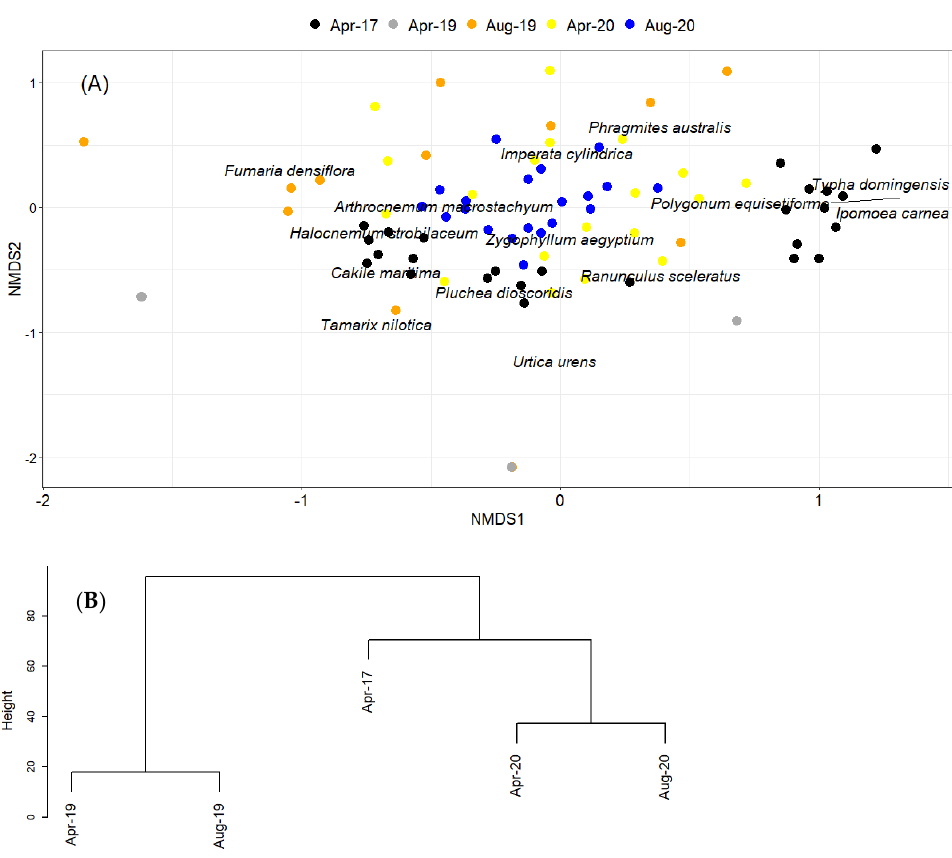
Figure 1. ( A ) NMDS ordination of plots at different sampling events (displayed by colors) and the species recorded during the surveys. ( B ) Hierarchical clustering of plots at different sampling events. The Sørensen pairwise dissimilarity ( β sor ) showed that the plots sampled in 2020 are less dissimilar in comparison to the plots sampled in 2019 (Figure